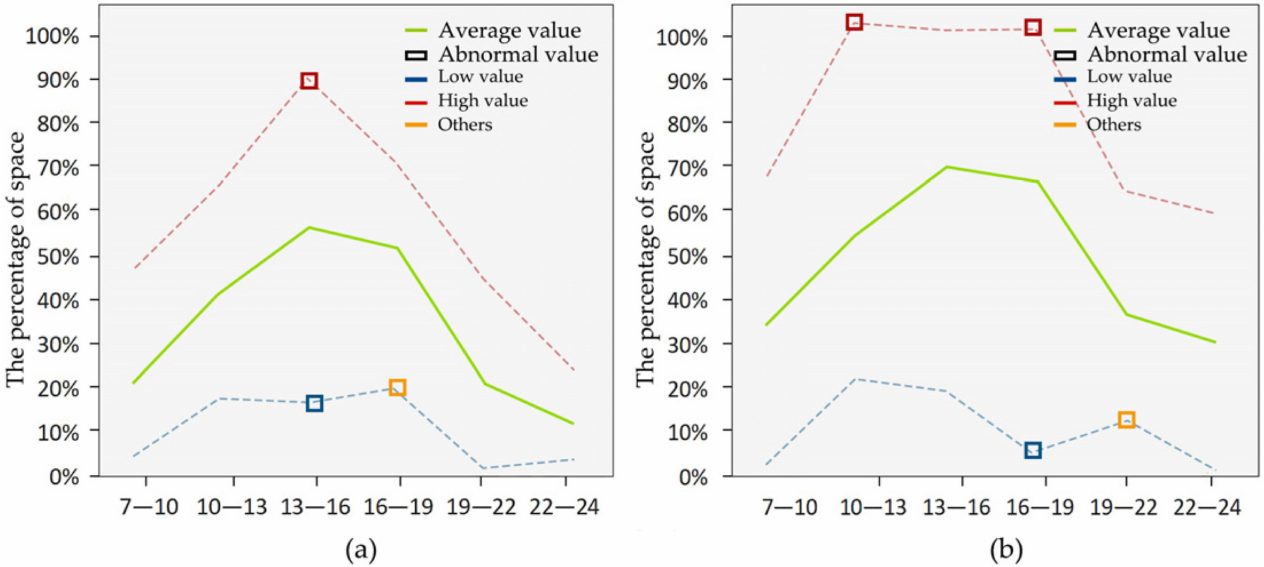
Figure 4. Proportion of space with vitality above level 3 on weekdays ( a ) and weekends ( b ).